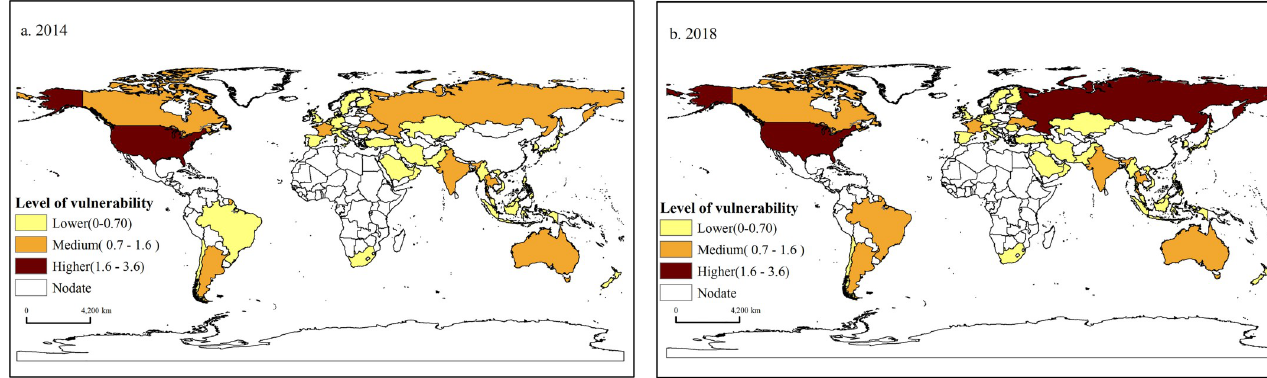
Fig 1. Spatial pattern of the vulnerability of China’s grain trade in 2014 and 2018.